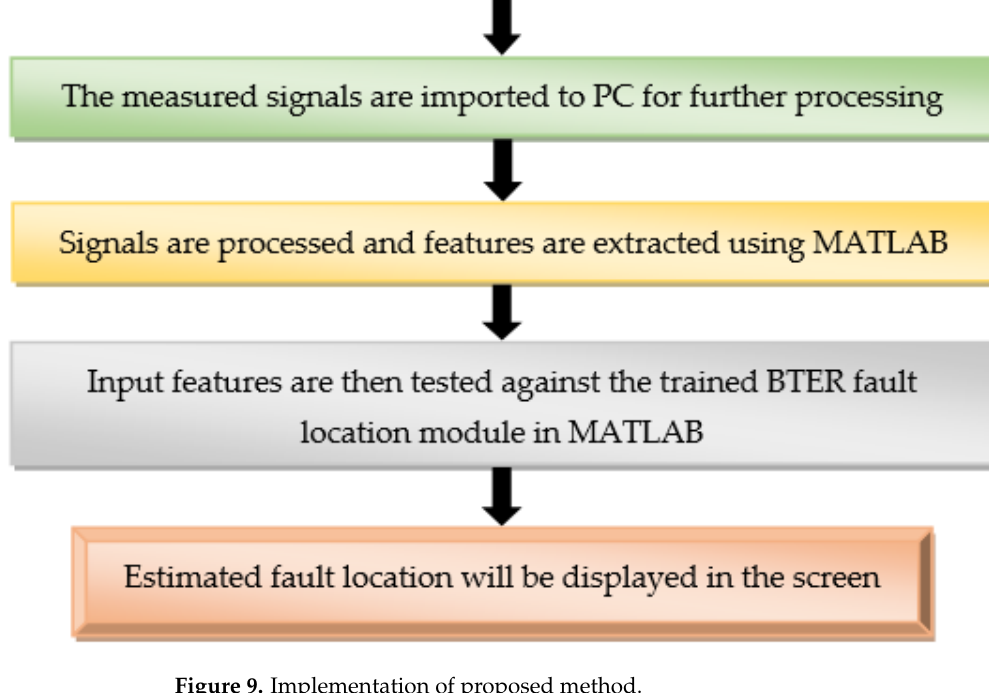
Figure 9. Implementation of proposed method.